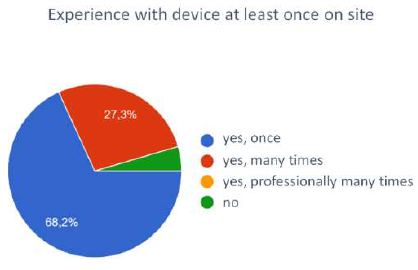
Figure 6: On-site experience with 3D laser scanner.